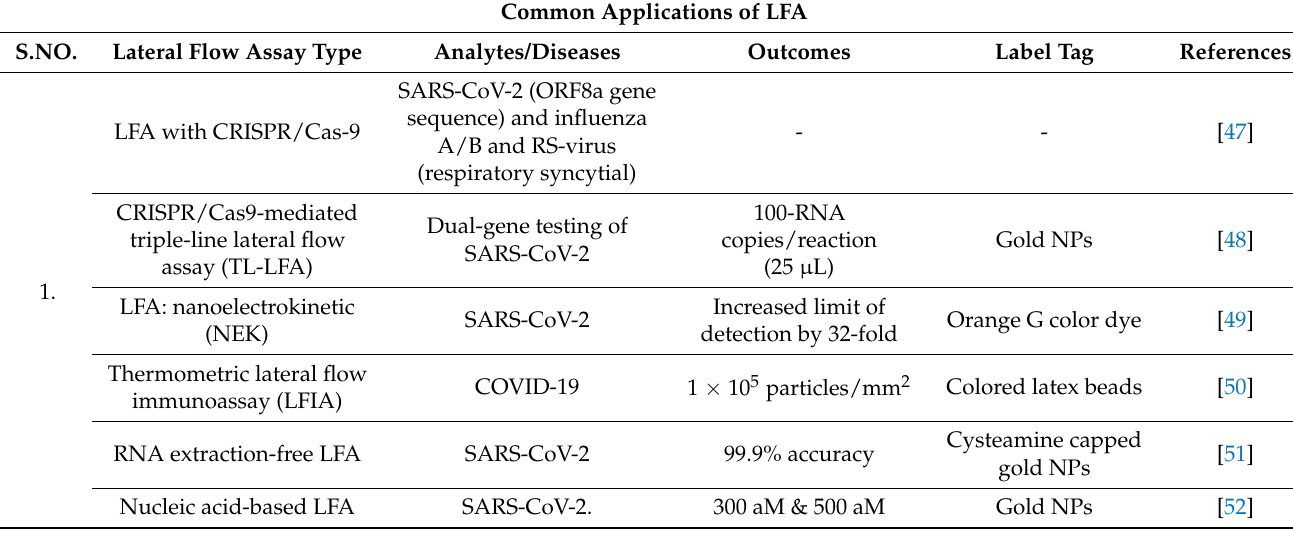
Figure 3. Futuristic e-LFA (electronic Lateral Flow Assay) device that encompasses microfluidics, electronics, and data processing on a single LFA strip. Table 2. Summary of different applications based on